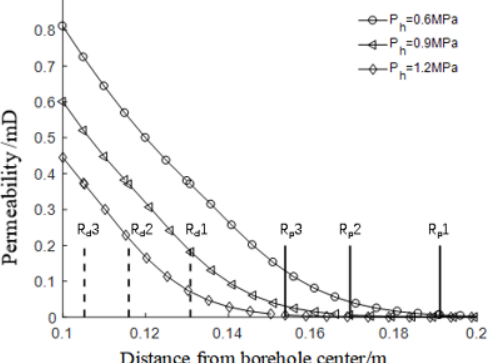
Figure 8. The change in coal rock permeability around borehole under different fracturing pressure.